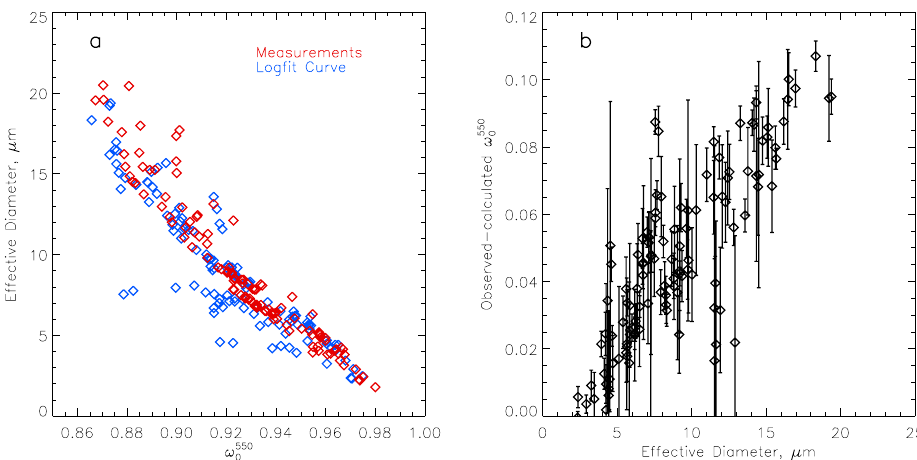
Fig. 8. (a) Comparison of d eff to ω 550 using measurements of the full size distribution. Red points indicate size distributions using the 0 measured data, blue points indicate data calculated from logfits to the size distribution. (b) Overestimate of measured ω 550 mode only) compared to calculated ω 550 (full size range) as a function of effective diameter. Each data point represents one horizontal leg. 0 Error bars show uncertainty in measurement SSA due to atmospheric variability across each horizontal leg.